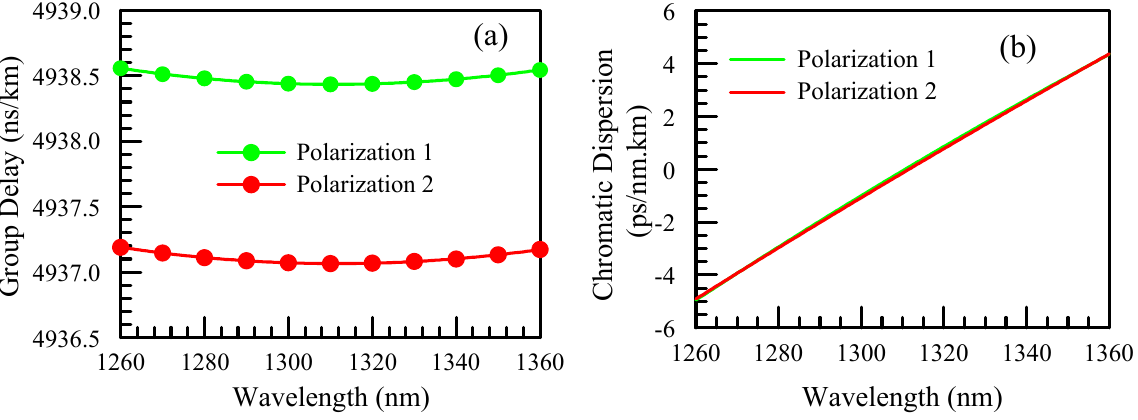
Figure 6. ( a ) Group delay as a function of wavelength for PMF around 1310 nm; ( b ) Chromatic dispersion as a function of wavelength for PMF around 1310 nm.